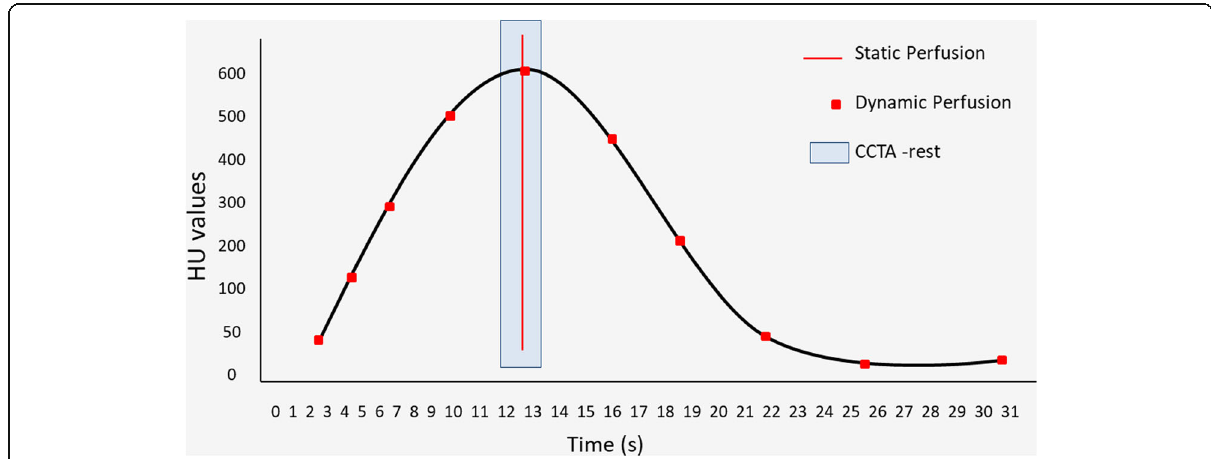
Fig. 1 Schematic representation of the imaging time points for static (red line) and dynamic (red dots) perfusion imaging. Each capturing a specific part of the contrast enhancement curves measured in both the aorta (arterial input function) and myocardial tissue (tissue attenuation curve). Both techniques can be acquired at rest or stress. The blue box represents the optimal time window for coronary CT angiography imaging during